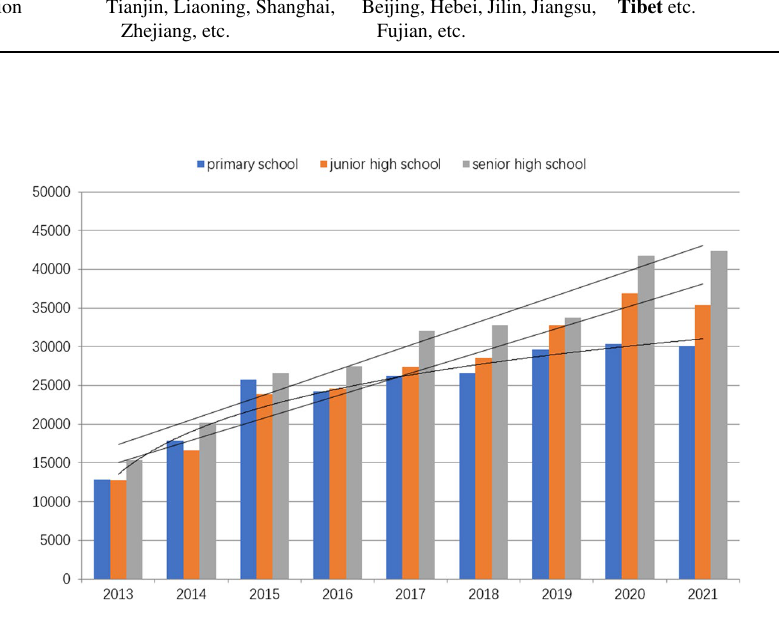
Fig. 7 Education funding per student in Tibet